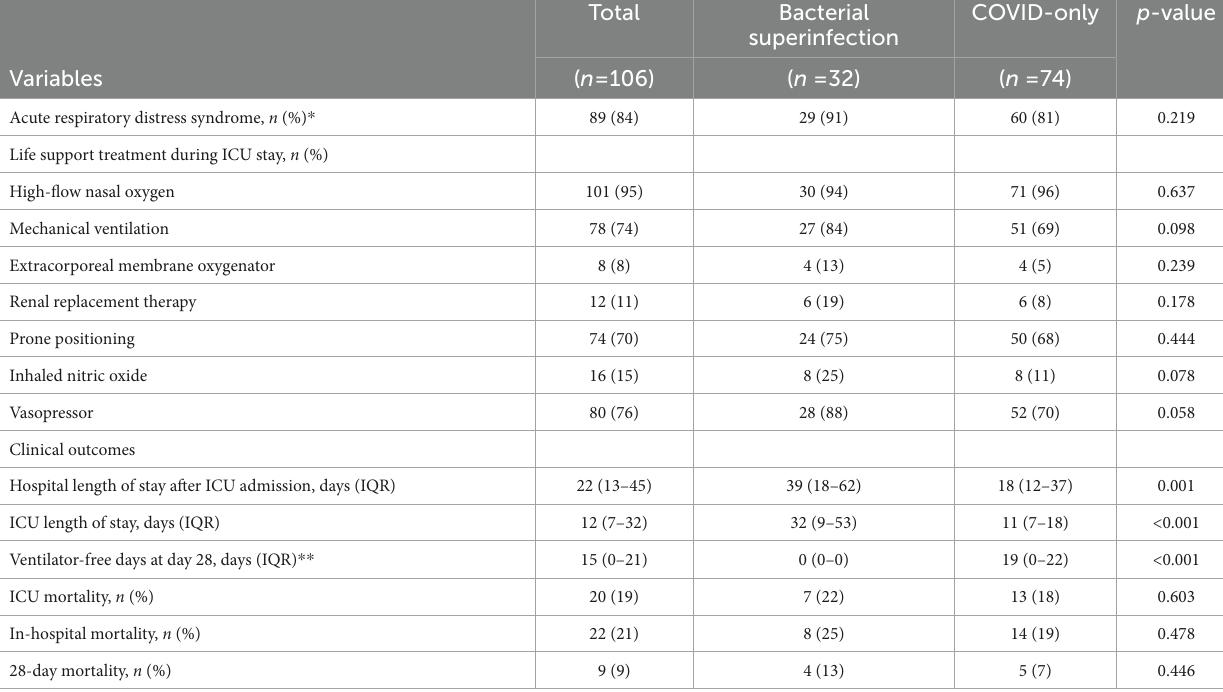
TABLE 2 Interventions and clinical outcomes in critically ill patients with COVID-19.